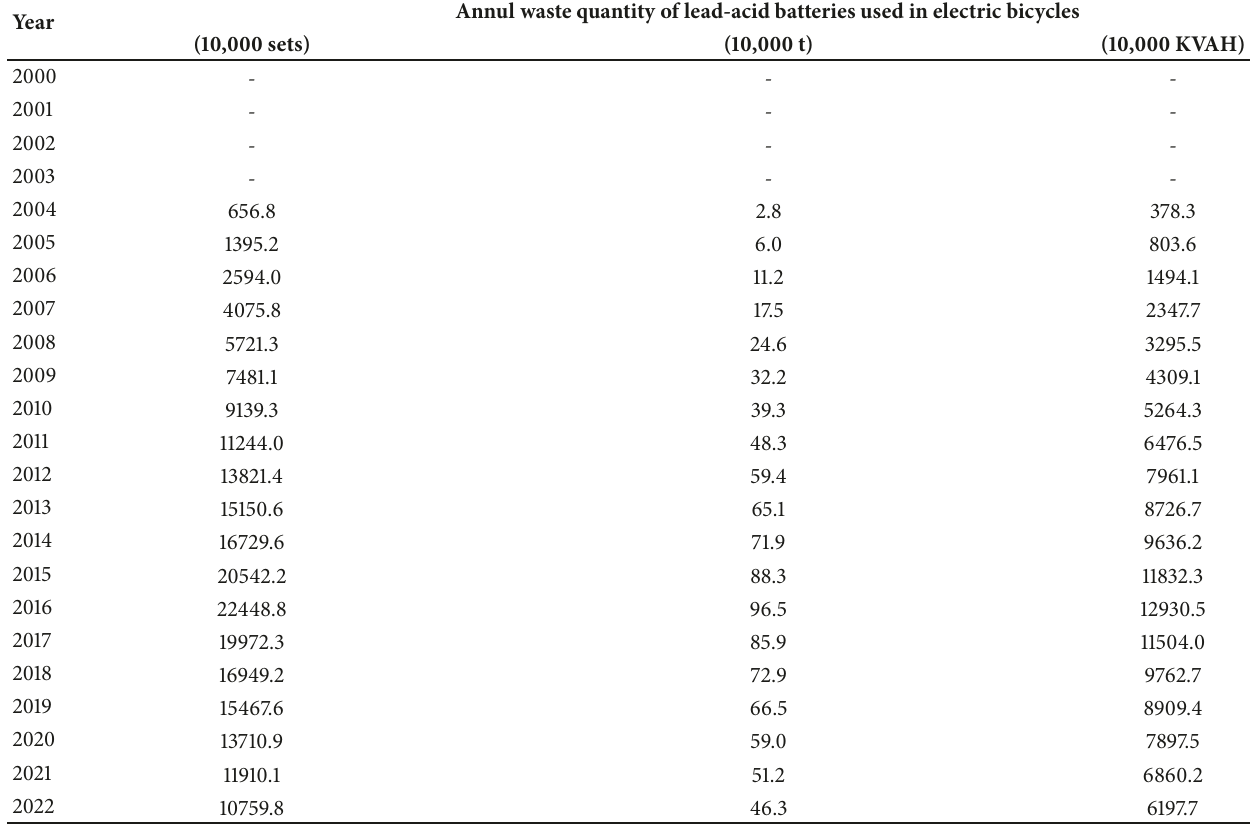
Table 12: “Stanford Model” based annual waste quantity of lead-acid batteries used in electric bicycles in 2000-2022.